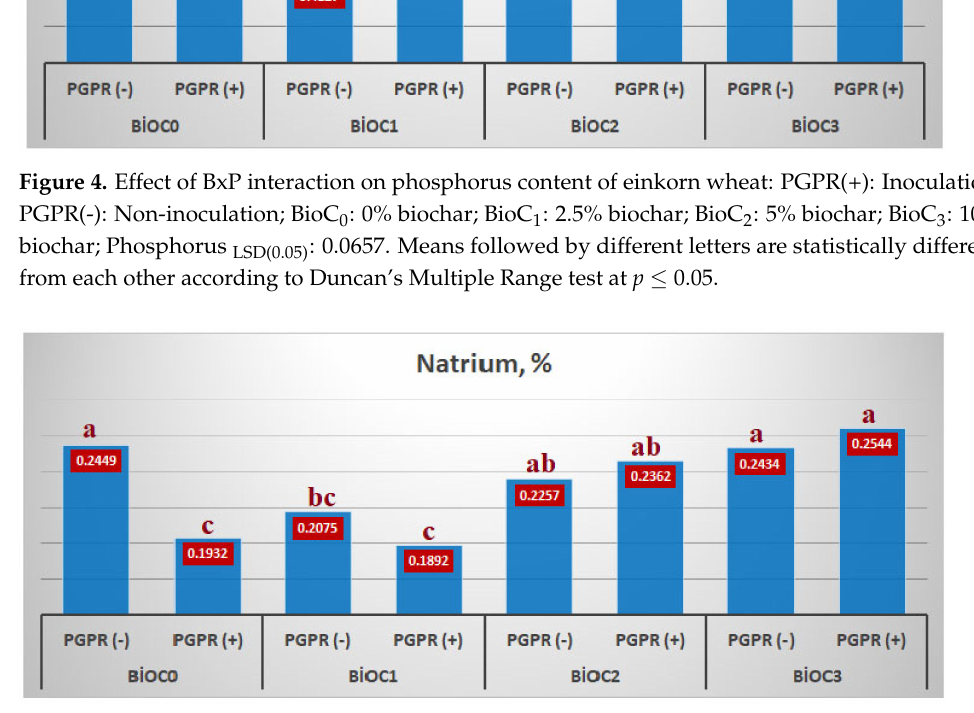
Figure 5. Effect of BxP interaction on natrium content of einkorn wheat: PGPR(+): Inoculation; PGPR(-): Non-inoculation; BioC 0 : 0% biochar; BioC 1 : 2.5% biochar; BioC 2 : 5% biochar; BioC 3 : 10% biochar; Natrium LSD(0.05) :0.0304. Means followed by different letters are statistically different from each other according to Duncan’s Multiple Range test at p ≤